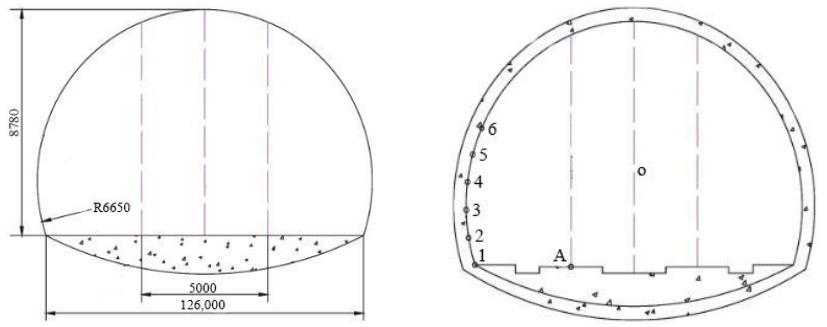
Figure 5. Tunnel contour and measuring point position.